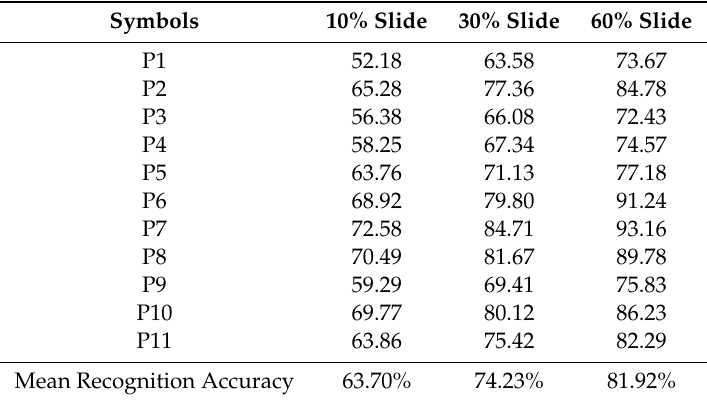
Table 2. IM-WSHA dataset results for di ff erent sliding windows.